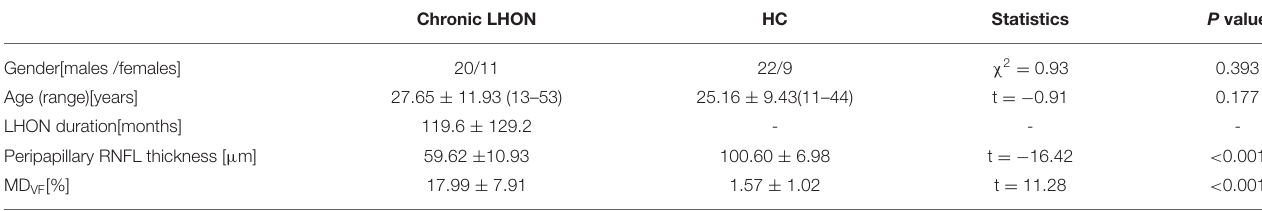
TABLE 1 | Demographic information of the recruited